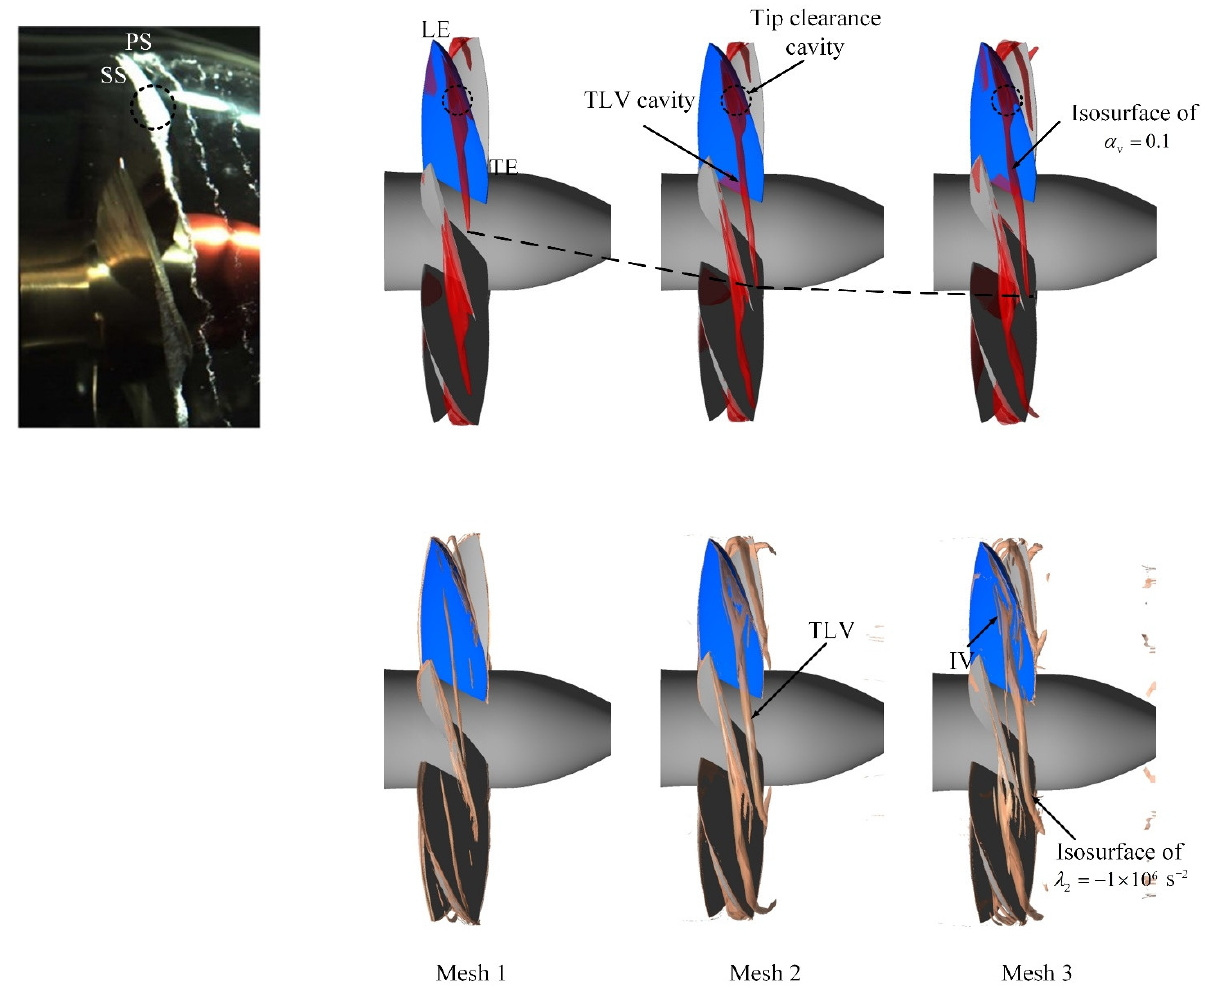
Figure 4. Measured [33] and predicted cavitation regions and predicted vortex structures.